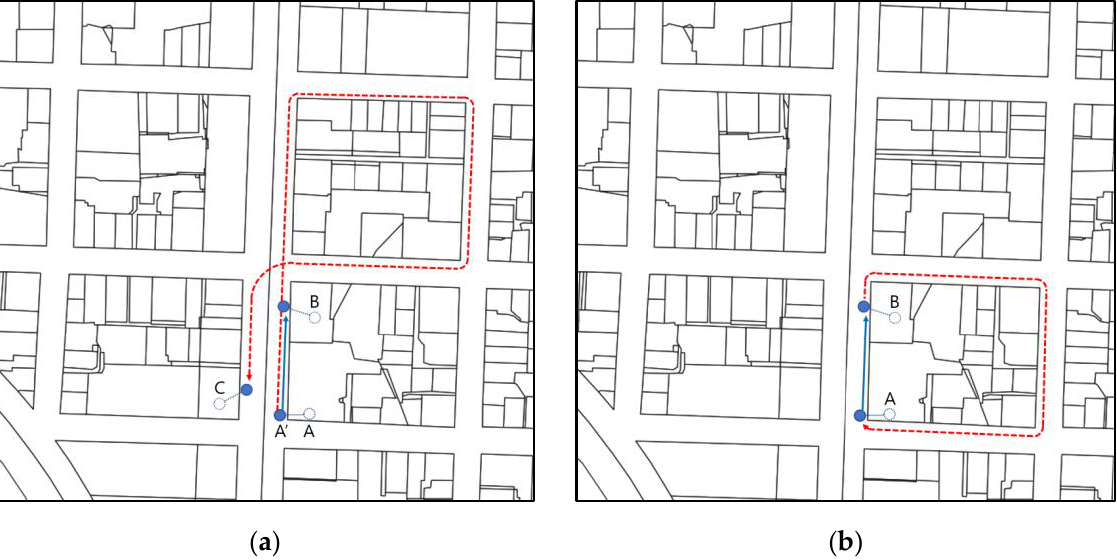
Figure 1. A figurative explanation on using map APIs: ( a ) The air distance underrepresents the actual travel distance; ( b ) the outbound and return trip costs are different.